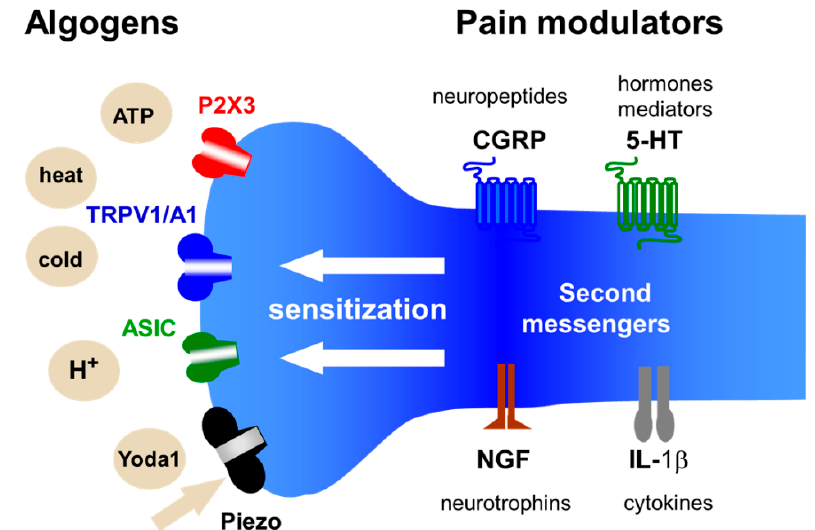
Figure 1. Chemical and physical stimuli (algogens) activating ion channel of nociception and pain modulators acting at the nerve terminal of the nociceptive neuron. The nerve terminal expresses specific ion channels of nociception such as ATP-gated P2X3, heat/capsaicin-sensitive TRPV1 and cold/redox-sensitive TRPA1 channels, acid-sensitive ion channels (ASICs) and mechanosensitive Piezo channels. The activity of these pain transducers can be enhanced leading to the neuronal sensitization, via metabotropic receptors, by different classes of pain modulators including neuropeptides, hormones, classical mediators, neurotrophins, cytokines, and other endogenous pro-nociceptive molecules.